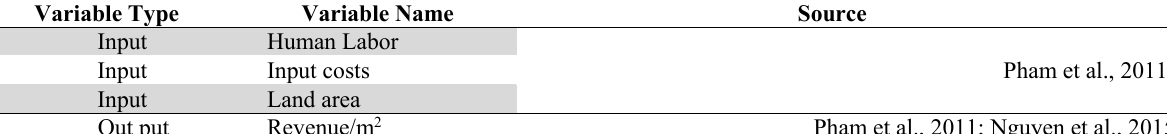
Description, basis of variables in marginal production function model Variable Type